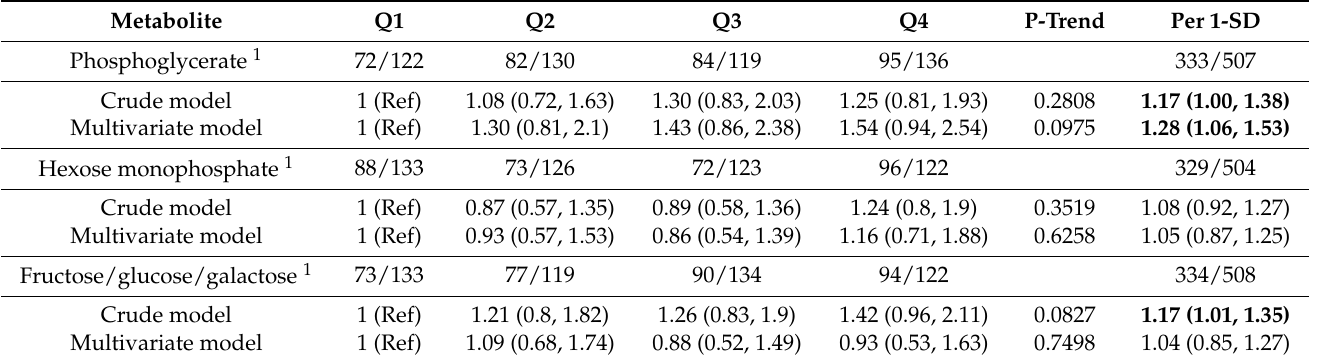
Table 3. Association between baseline plasma glycolysis species and other related metabolites and incident heart failure.